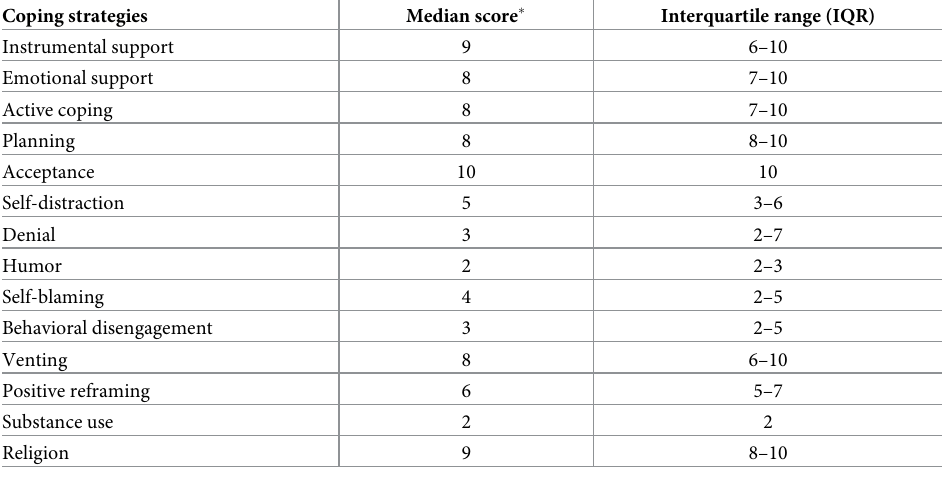
Table 3. Coping strategies adopted by the patients (n =